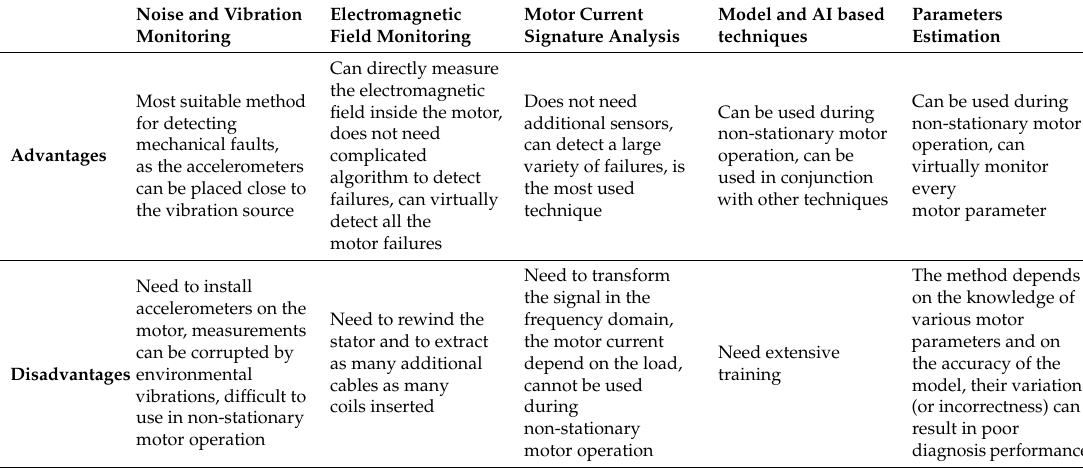
Table 12. Techniques summary